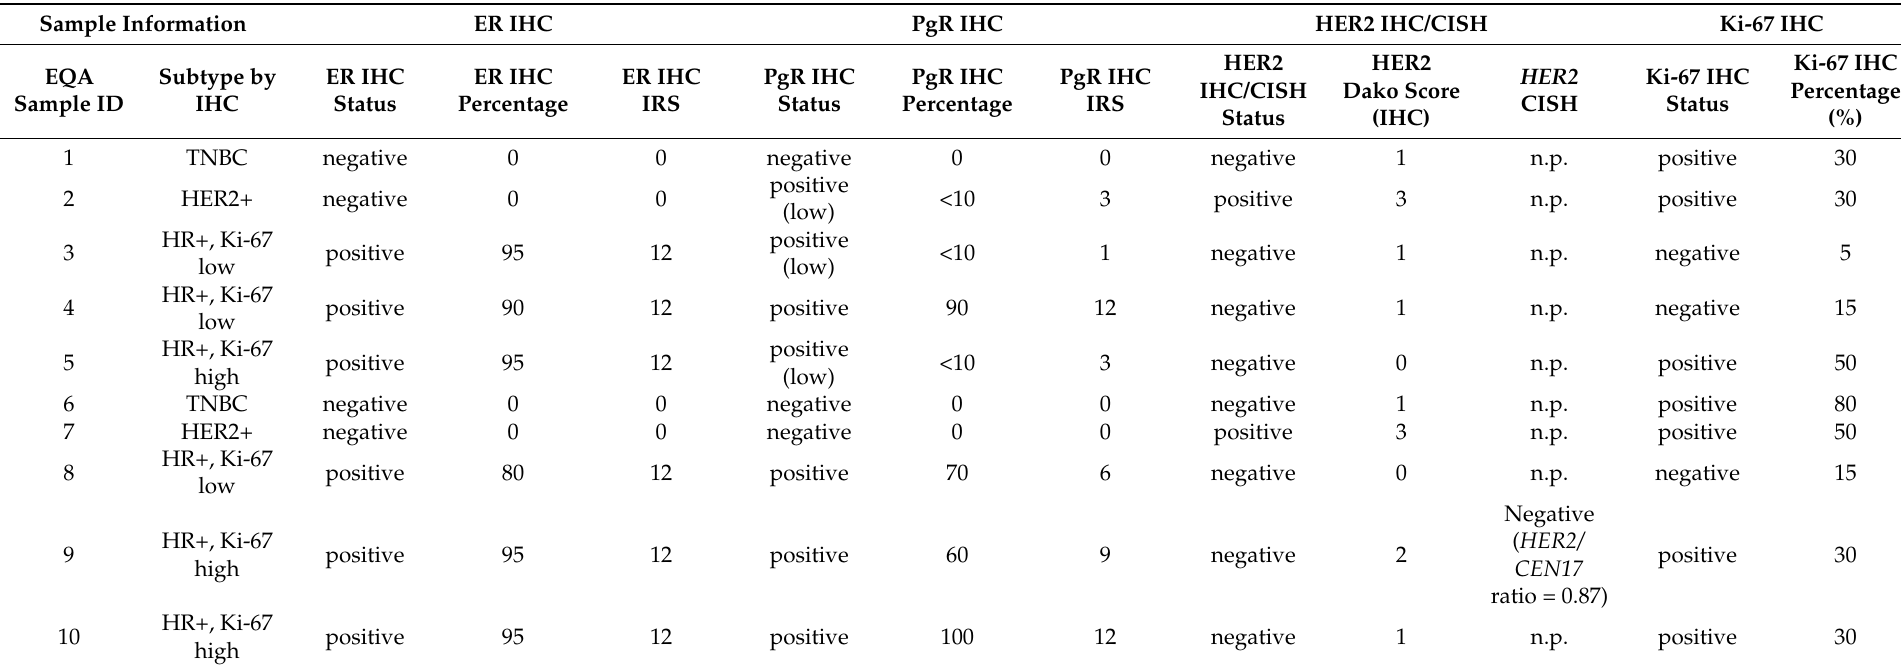
Table 1. IHC/ISH subtyping of the EQA study cohort. Positivity of either ER and/or PgR are summarized as hormone receptor-positive (HR+). CEN17 : centromere of the corresponding chromosome 17; n.p.: not